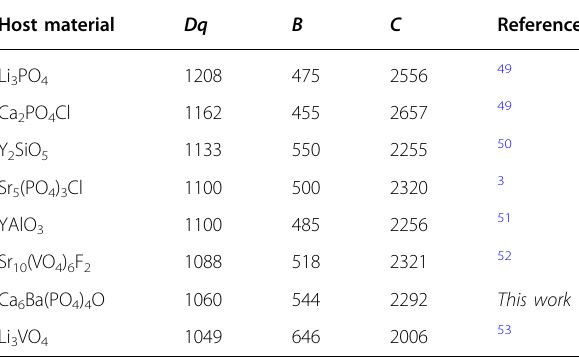
Table 5 Comparison of the Dq , B and C parameters (all in cm − 1 ) for the tetrahedrally coordinated Mn 5 + ions in different crystalline solids Host material